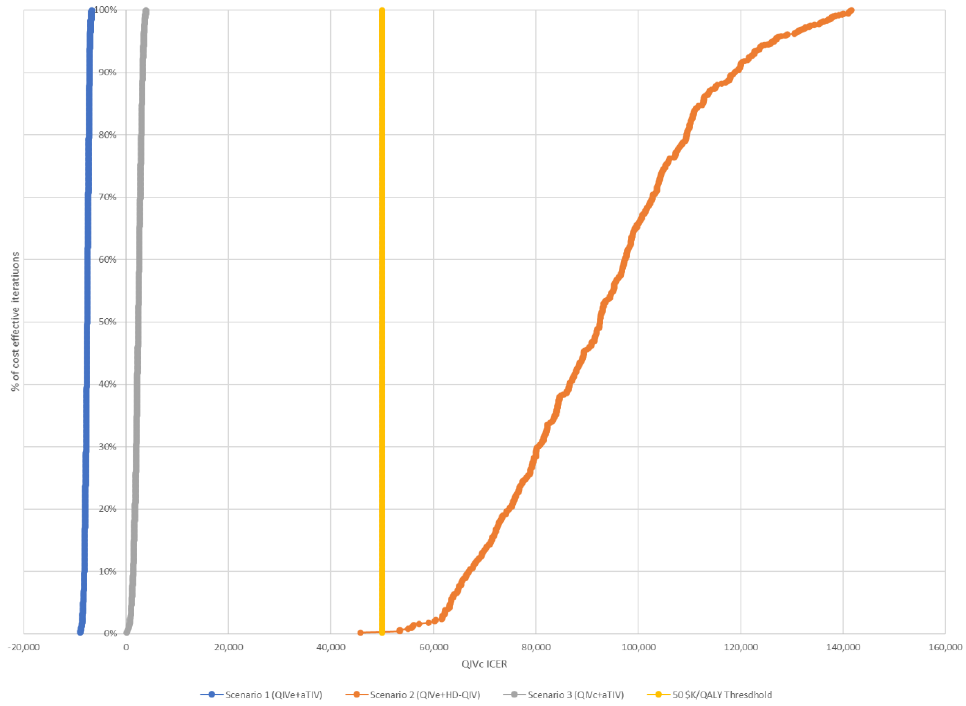
Figure 4. Cost-effectiveness acceptability curves for each of the three scenarios, assuming six egg- adapted seasons. The threshold for cost-effectiveness was CAD